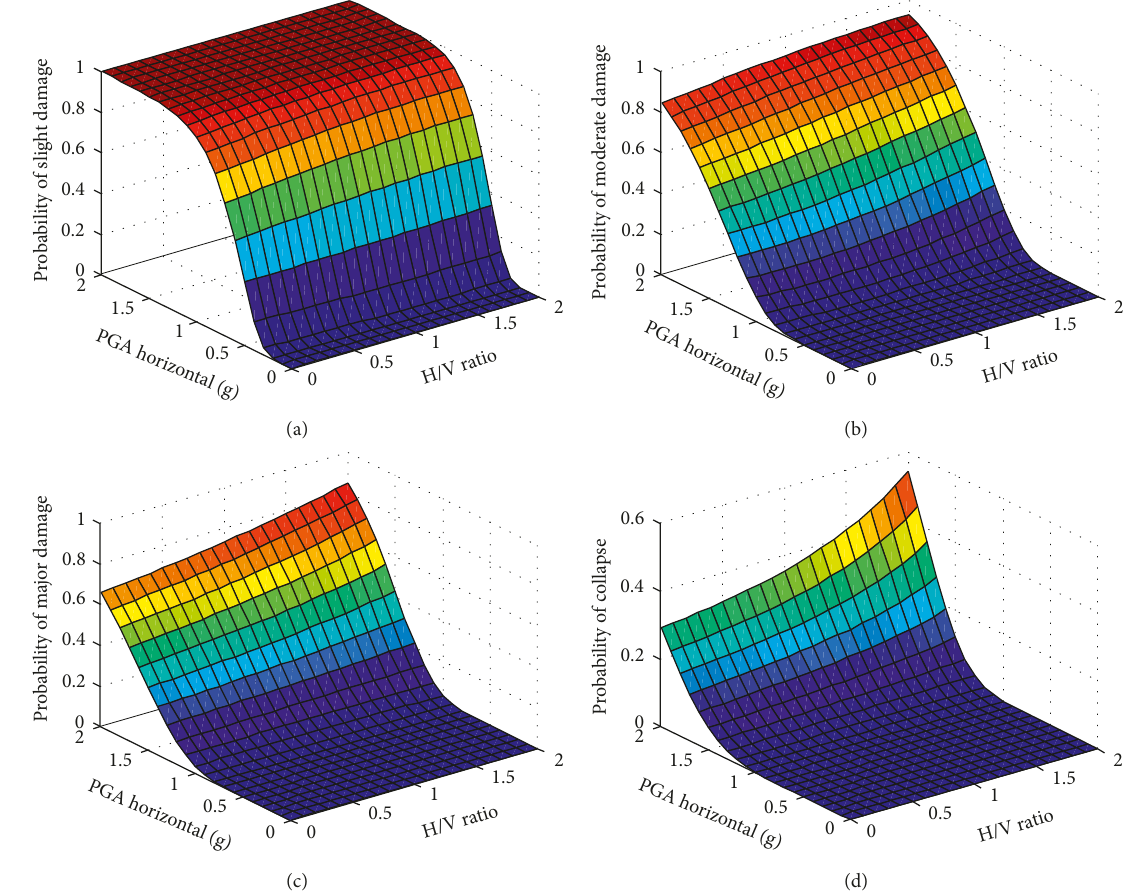
Figure 4: Fragility surfaces for different damage states: (a) slight; (b) moderate; (c) major; and (d)